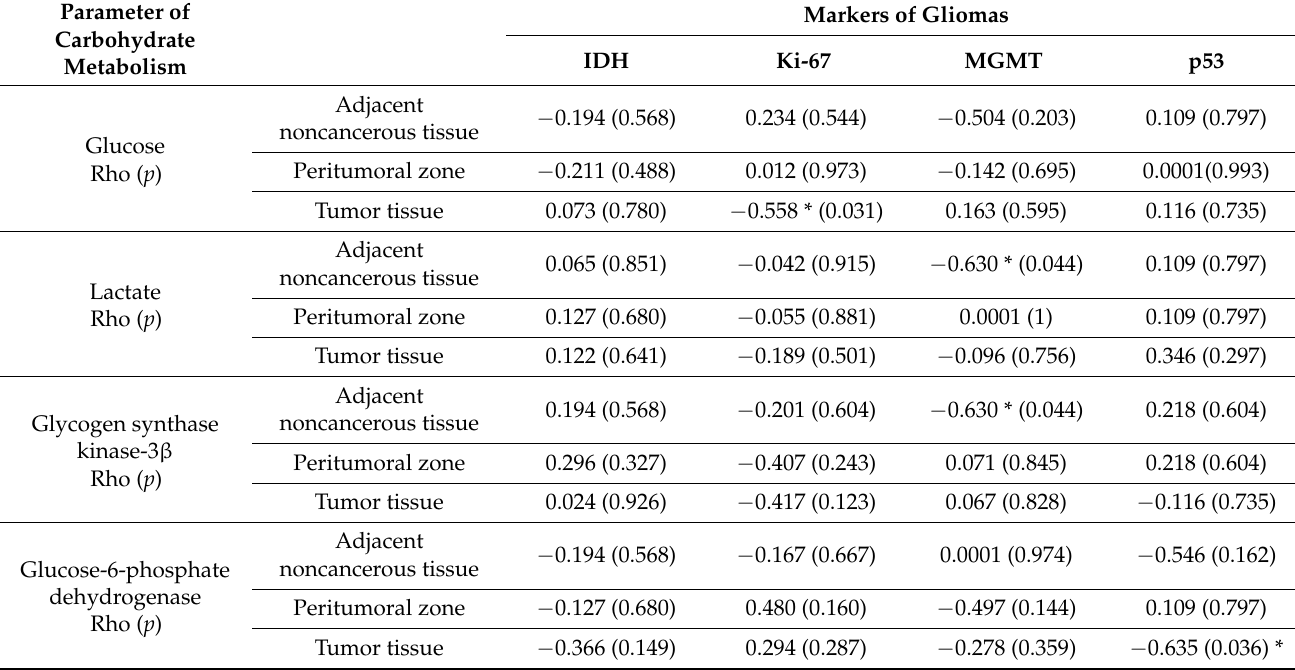
Table 3. Correlations (the Spearman’s coefficient) between immunohistochemical markers of gliomas and parameters of carbohydrate metabolism of brain tumors in 20